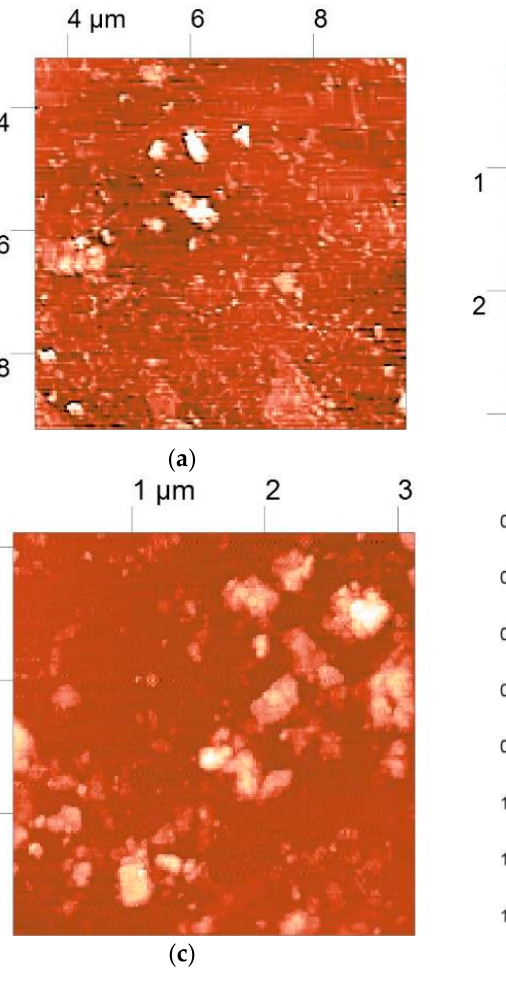
Figure 7. Atomic force microscopy (AFM) images of DNA-polyplexes with TMAB-CS ( a ), Pyr-CS ( b ), and PyrTMAB-CS ( c , d ).